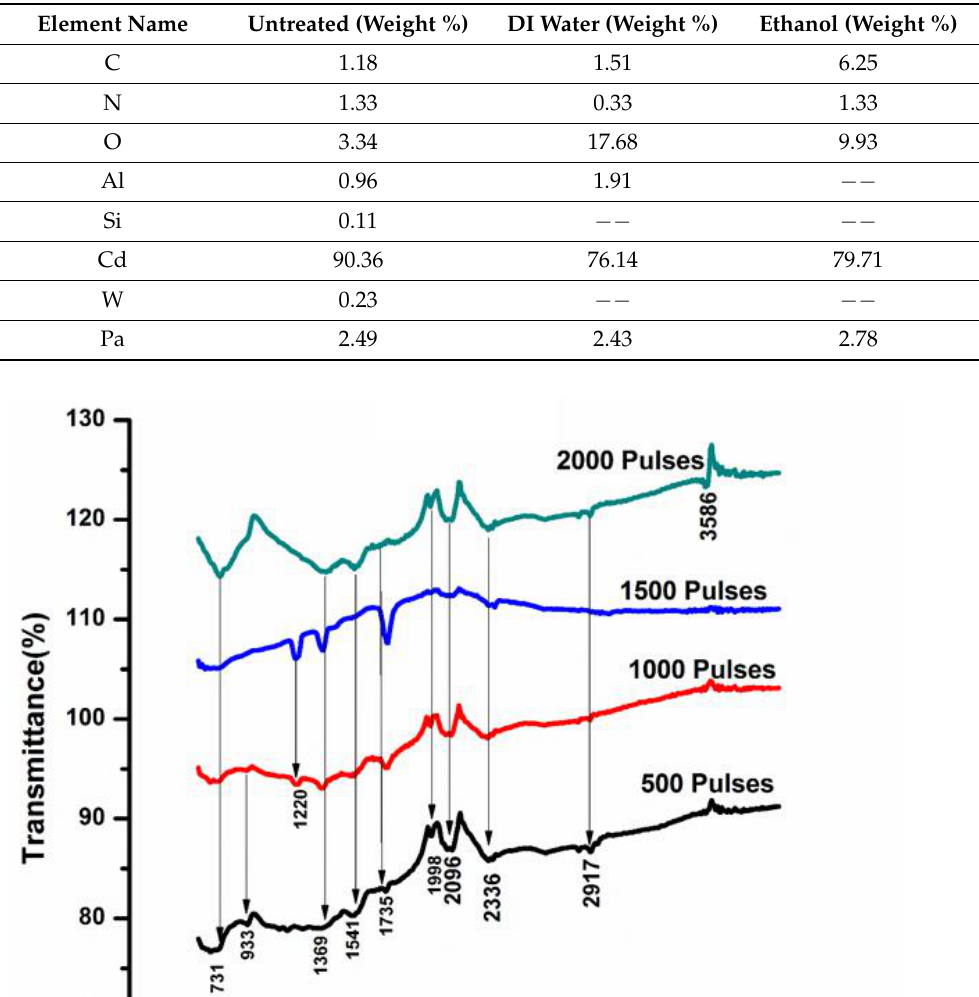
Table 3. EDS analysis of untreated and treated Cd exposed to 500, 1000, 1500, and 2000 laser pulses at a constant fluence value of 3.6 Jcm − 2 in DI water and ethanol.